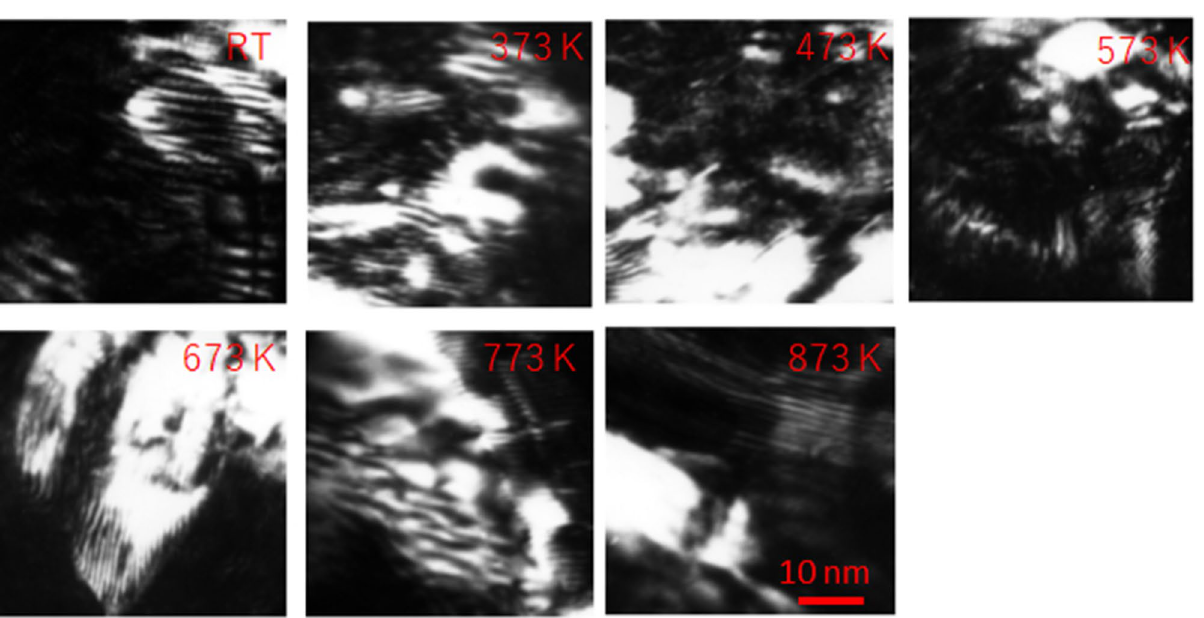
Figure 2. Microstructures in deformed CoCrFeMnNi. The sample was deformed at room temperature at a strain rate of 10 6 /s. Dark-field weak-beam TEM images of microstructures along [110] direction before and after annealing at various temperatures (room temperature to 873 K with increments of 100